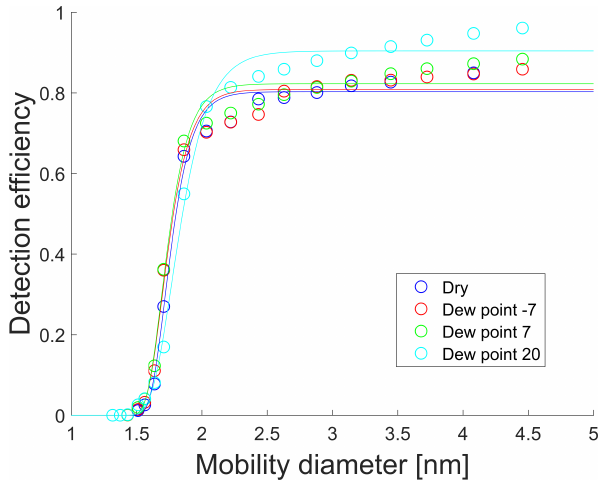
Figure 13. Detection efficiency of the B3010 as a function of the inlet flow rate.